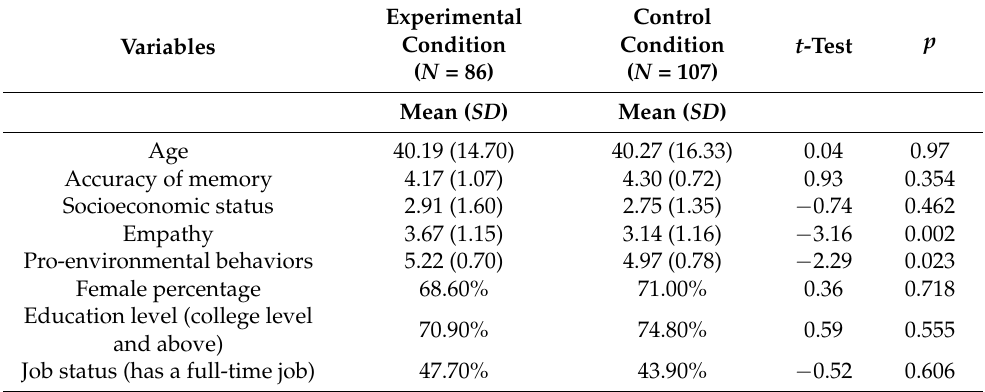
Table 2. Descriptive information of variables used in Study